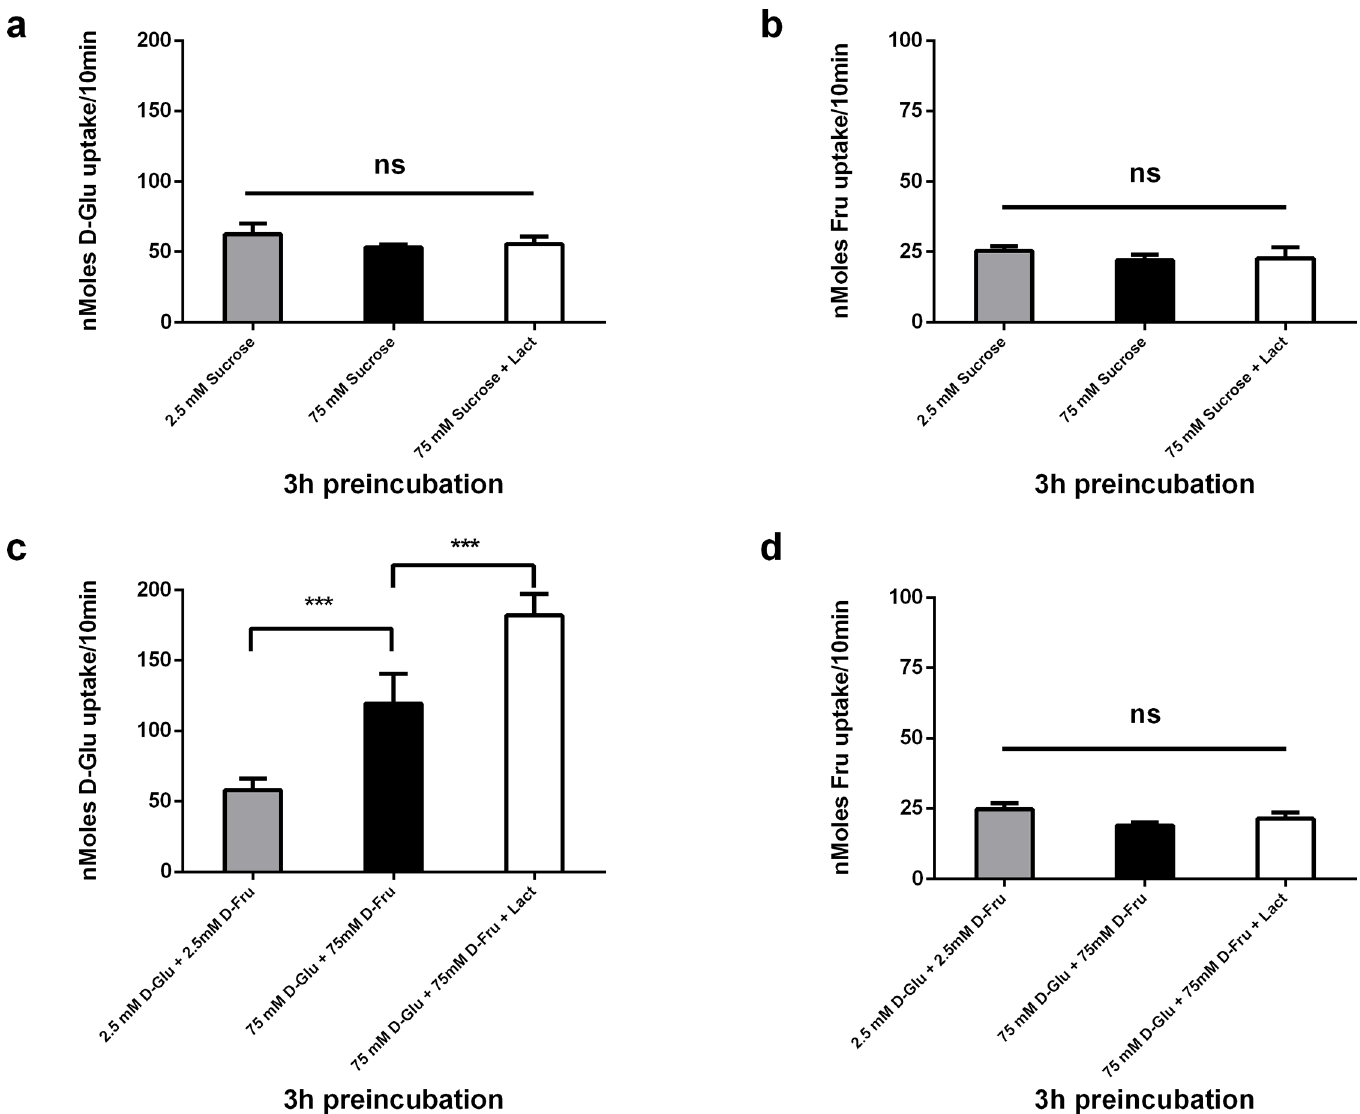
Fig 6. Acute effects of Sucrose, an equimolar mix of free glucose and fructose, and lactisole on carriermediated [ 14 C] 10 mM D-Glucose and D-Fructose uptake into Caco-2/TC7 cells. Caco-2/TC7 cells grown for 21 days were incubatedwith 2.5 and 75 mM Sucrose or a 50/50 mix of free D- Glucose/D-Fructose in the presenceor absenceof 0.5 mM lactisolefor 3hrs, washedin sugar free KBS. (a) and (c) are cellularuptake of [ 14 C] 10 mM D-Glucosefor 10 mins (b) and (d) are cellularuptake of [ 14 C] 10 mM D-Fructose measuredby radioactive scintillation spectrometry. Osmolarity was adjusted by addingMannitol.Uptake is corrected for simple diffusionof 10 mM [ 14 C] L-Glucose. Data are expressedas nMoles sugar uptake/well/10min ± SD of n = 4 per condition. * P < 0.05, ** P < 0.01, *** P < 0.001, ns = not significant.